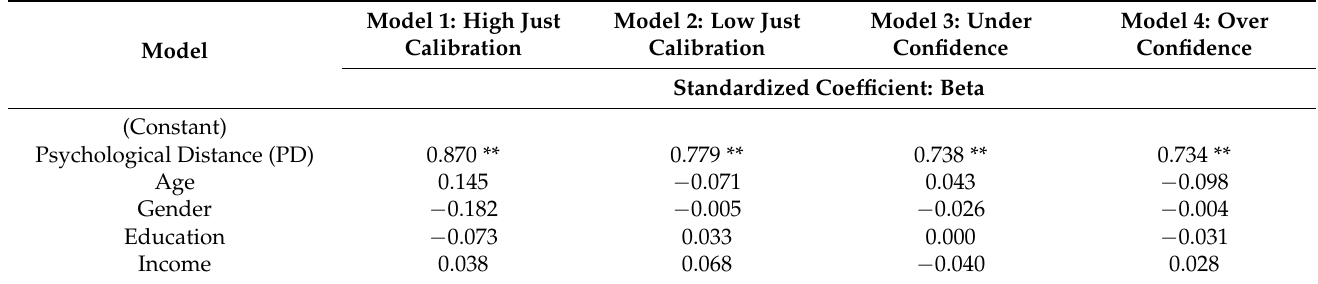
Table 2. Results of multiple regression